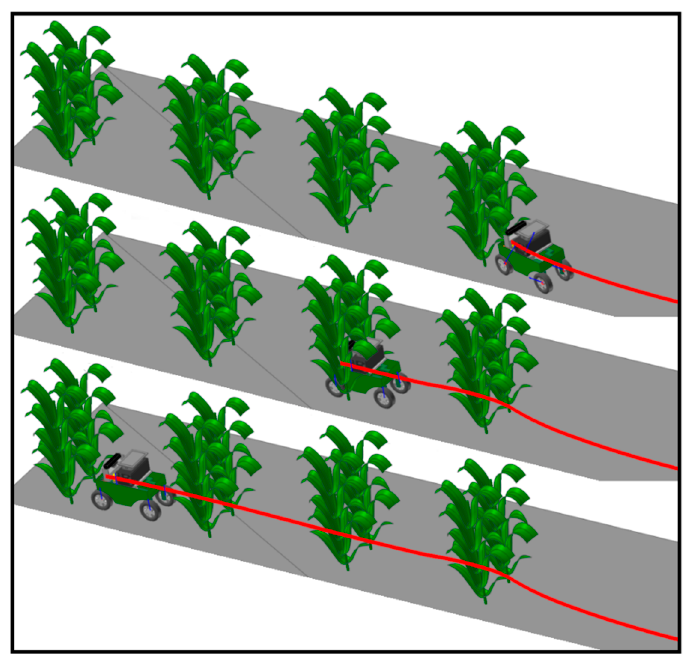
Figure 16. Real time simulation result chart.